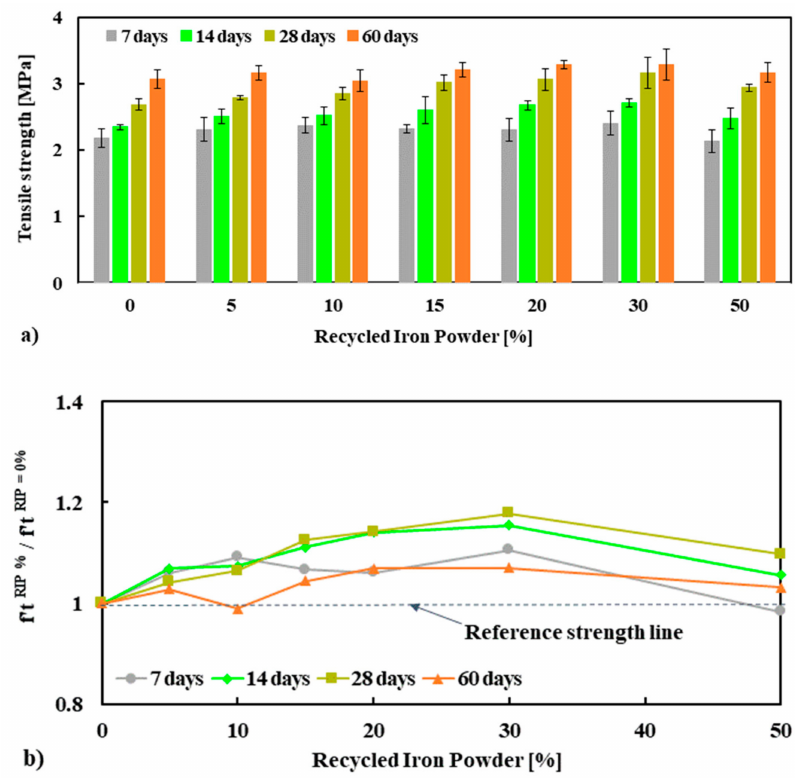
Figure 5. Tensile strength (f (cid:48) t) ( a ) and normalized f (cid:48) t ( b ) of mortar specimens conducted at 7, 14, 28 and 60